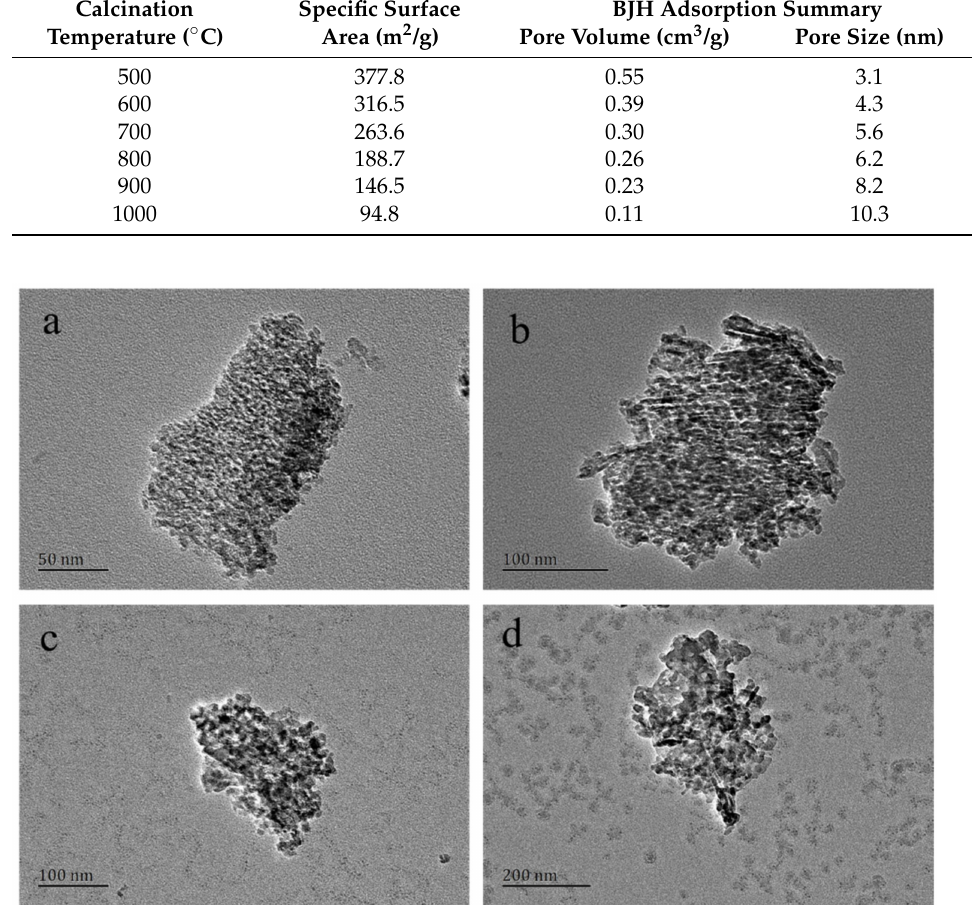
Figure 3. TEM images of the MA powders calcined under various temperatures: ( a ) 500 ◦ C; ( b ) 700 ◦ C; ( c ) 900 ◦ C; ( d ) 1000 ◦ C.